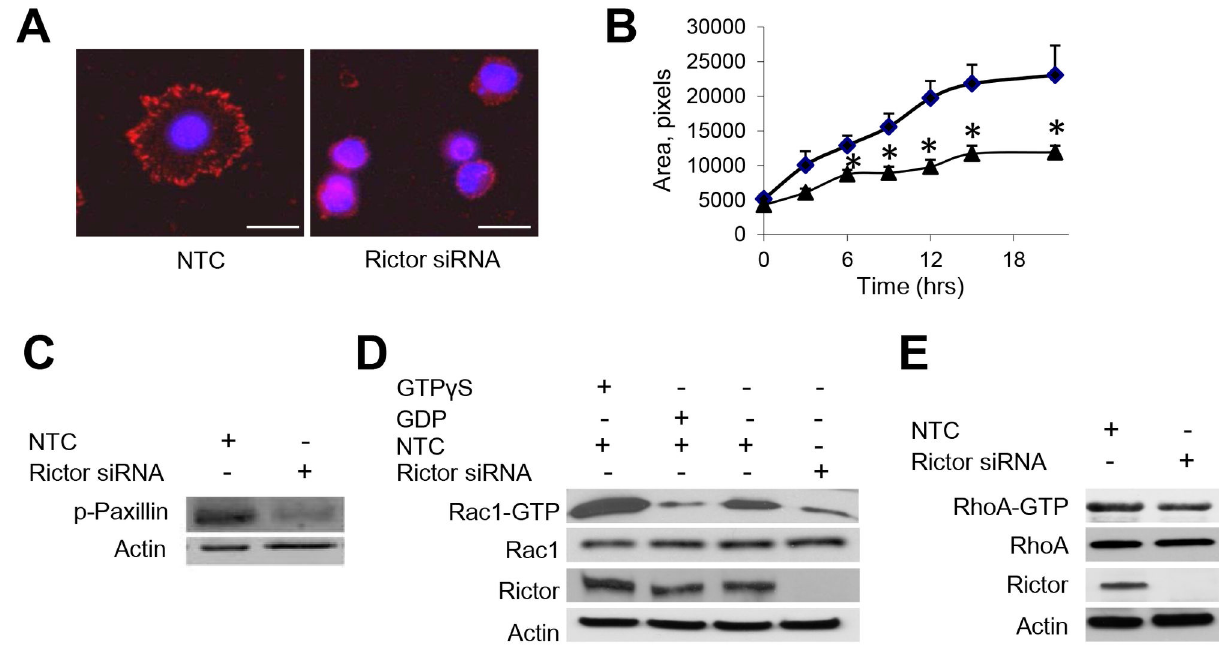
Figure 6. mTORC2 regulates cell spreading and Rac1 activity in bladder cancer cells. J82 cells were either transfected with rictor-specific siRNA or NTC siRNA 72 h prior to the start of the experiment. A , immunofluorescent staining shows broad cytoplasmic processes and peripheral phospho-paxillin in cells that are transfected with NTC siRNA. This is reduced in cells with rictor gene-silencing. Scale bar 30 microns. B , cell-surface areas were determined for J82 cells transfected with NTC (♦) or rictor- specific siRNA (▲) and allowed to spread for the indicated times (mean±SEM, n>15 for each time point; (*) p<0.05). C , immunoblotting for phospho-paxillin in J82 cells that were transfected with rictor-specific or NTC siRNA and allowed to adhere for 30 min. D , GTP-Rac1 was determined in J82 cells transfected with NTC or Rictor-specific siRNA. Rictor knockdown reduced Rac1 levels to 60.2% of control. Cells with GTPγS were analyzed as a positive control and GDP as negative control. E , GTP-loaded RhoA in J82 cells transfected with rictor-specific or NTC siRNA. Rictor knockdown reduced RhoA levels to 83.3% of